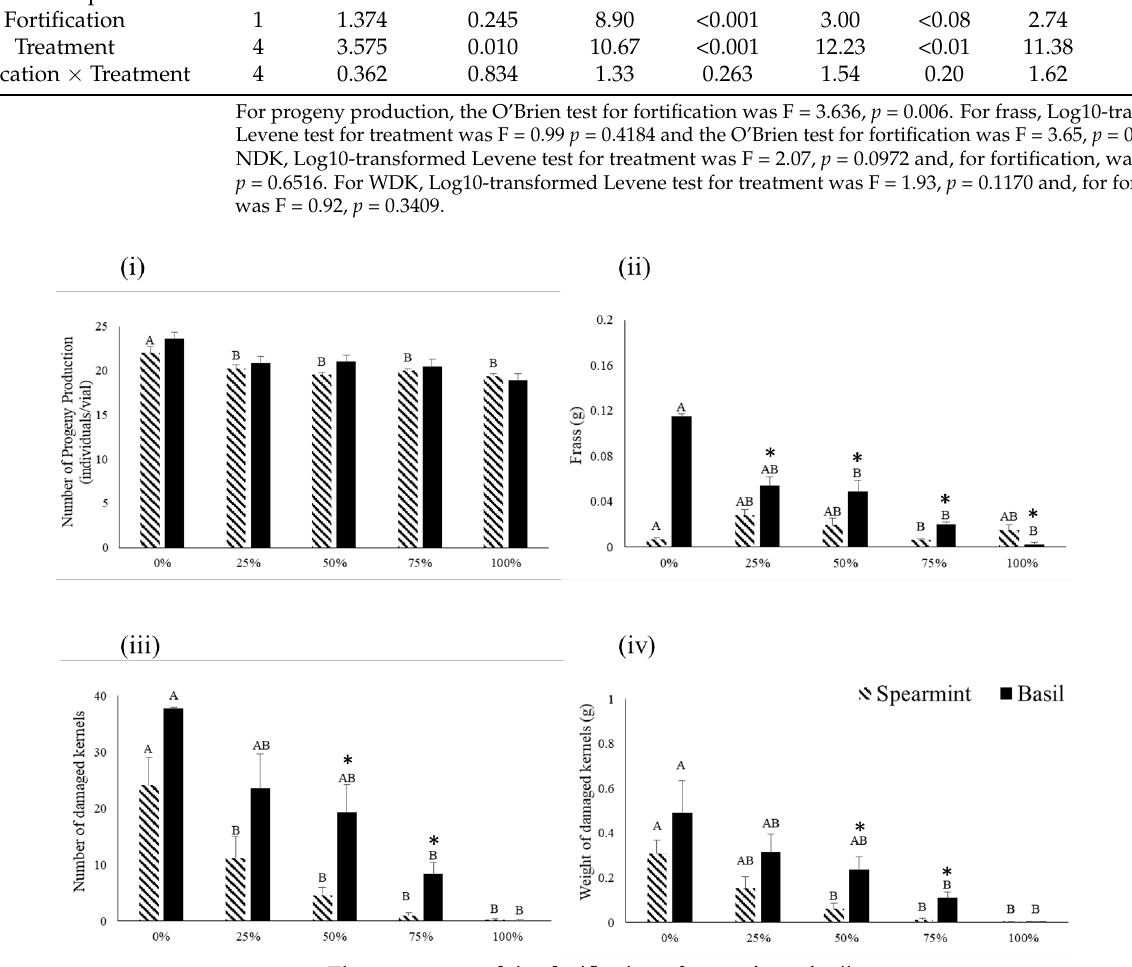
Figure 1. Mean ± of progeny production ( i ), frass ( ii ), number of damaged kernels ( iii ) and weight of damaged kernels ( iv ) of Sitophilus oryzae. Within each fortification (rice fortified with spearmint or basil) means followed by the same uppercase letter are not significantly different (Tukey-Kramer HSD test at 0.05). Where no letters exist, no significant differences were noted. Within each treatment, means with asterisks (*) indicated significant differences between the two fortified commodities (spearmint and basil ) tested according to Student’s t -test at 0.05. t -test parameters for frass at 25% were t = 6.794, p = 0.020; at 50%, were t = 6.671, p = 0.021; at 75% were t = 28.033, p < 0.001; and at 100% were t = 5.557, p = 0.033. For NDK, t -test parameters at 50% were t = 8.546, p < 0.011 and at 75% were t = 12.189, p = 0.003. For WDK, t -test parameters at 50% were t = 7.235, p = 0.017 and at 75% were t = 15.086, p = 0.0017. In all cases, df total = 39.